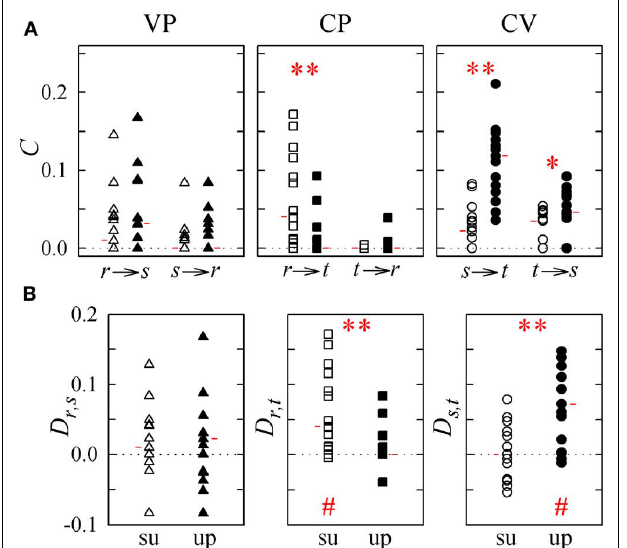
FIGURE 5 | Causal coupling index C (A) and directionality index D (B) computed for subjects in the supine position (su, white symbols) and in the upright position (up, black symbols) in the study of vasculo-pulmonary (VP, triangles), cardio-pulmonary (CP, squares), and cardio-vascular (CV, circles) coupling ( r : respiration, s : systolic pressure; t : heart period). Horizontal red marks denote the median of each distribution. * p < 0.05, ** p < 0.005 supine vs. upright; # p < 0.005, directionality index D is different from zero.